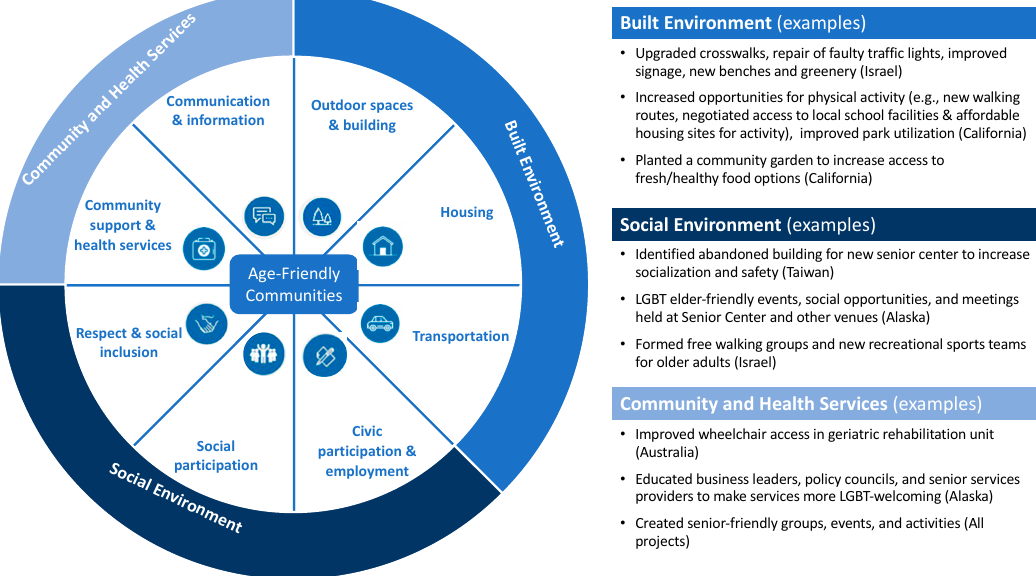
Figure 3. caption. Topic areas underlying global age-friendly communities, adapted from the WHO [33]. Figure 3. Topic areas underlying global age-friendly communities, adapted from the WHO